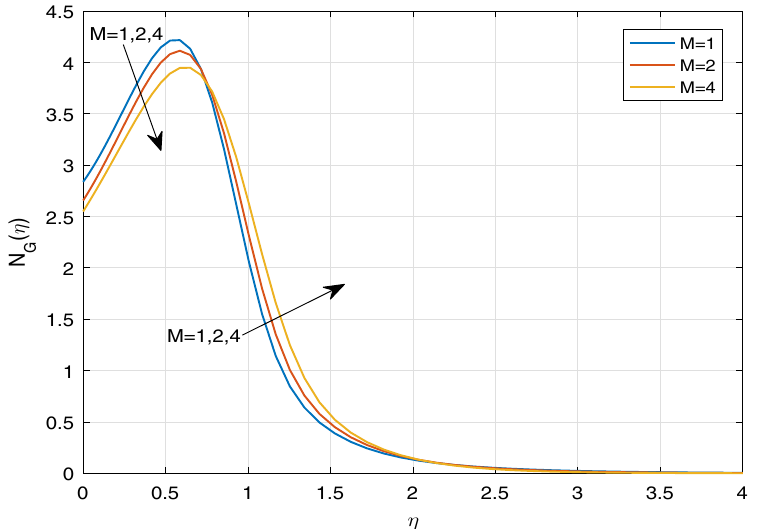
Figure 11. Sketch of N G against M .